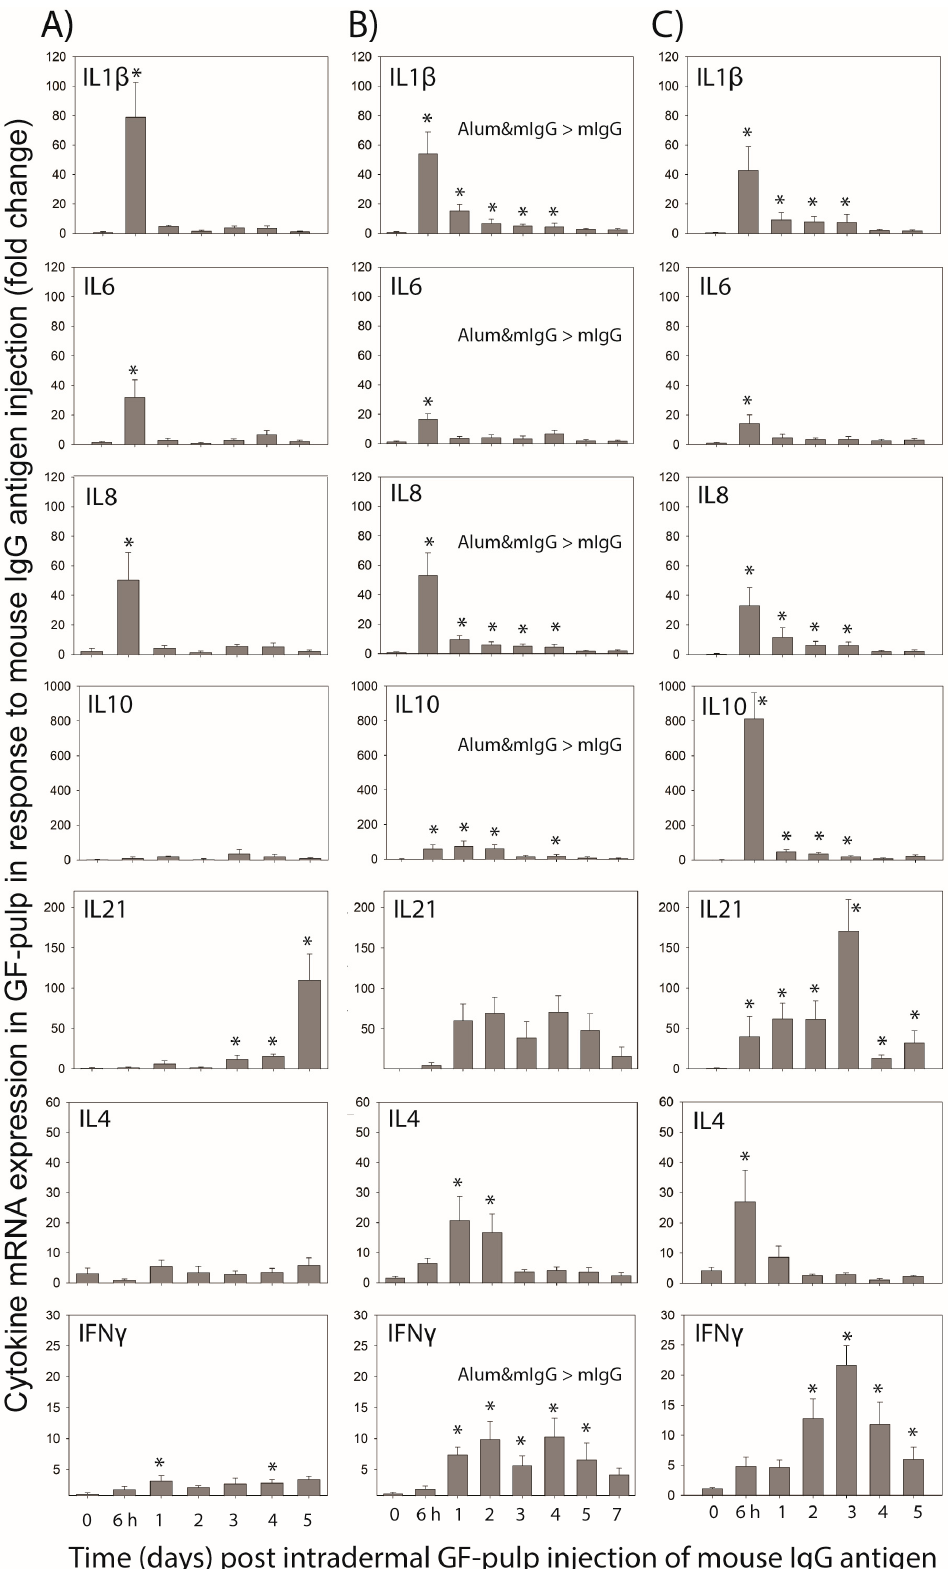
Figure 3. Relative mRNA expression of cytokine genes in response to intradermal injection of mouse IgG-antigen into the pulp of growing feathers (GF) in unsensitized (sham-(PBS) immunized) chickens ( A ), and in immunized chickens on Day 10 after the primary ( B ) or Day 5 after the secondary ( C ) intramuscular immunization with mouse IgG in PBS (mIgG) or mixed with alum adjuvant